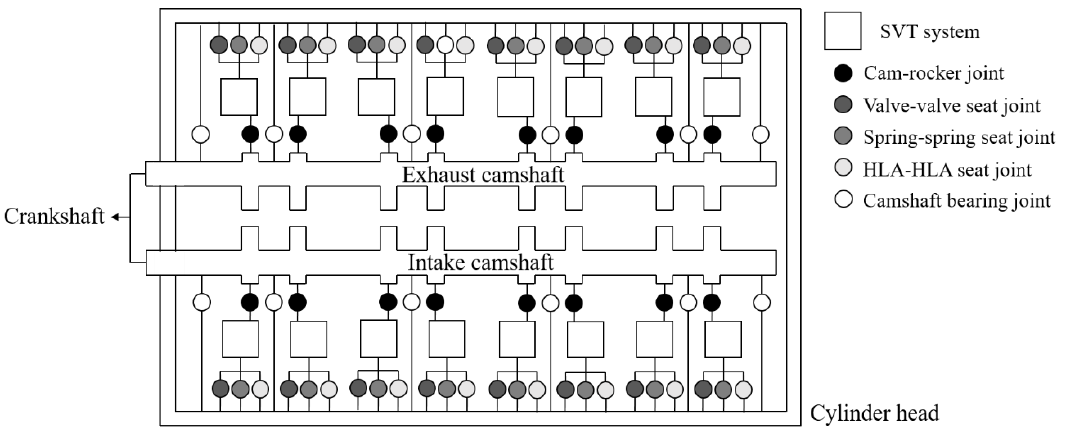
Figure 12. The structure of the intake and exhaust single valve train (SVT) system.